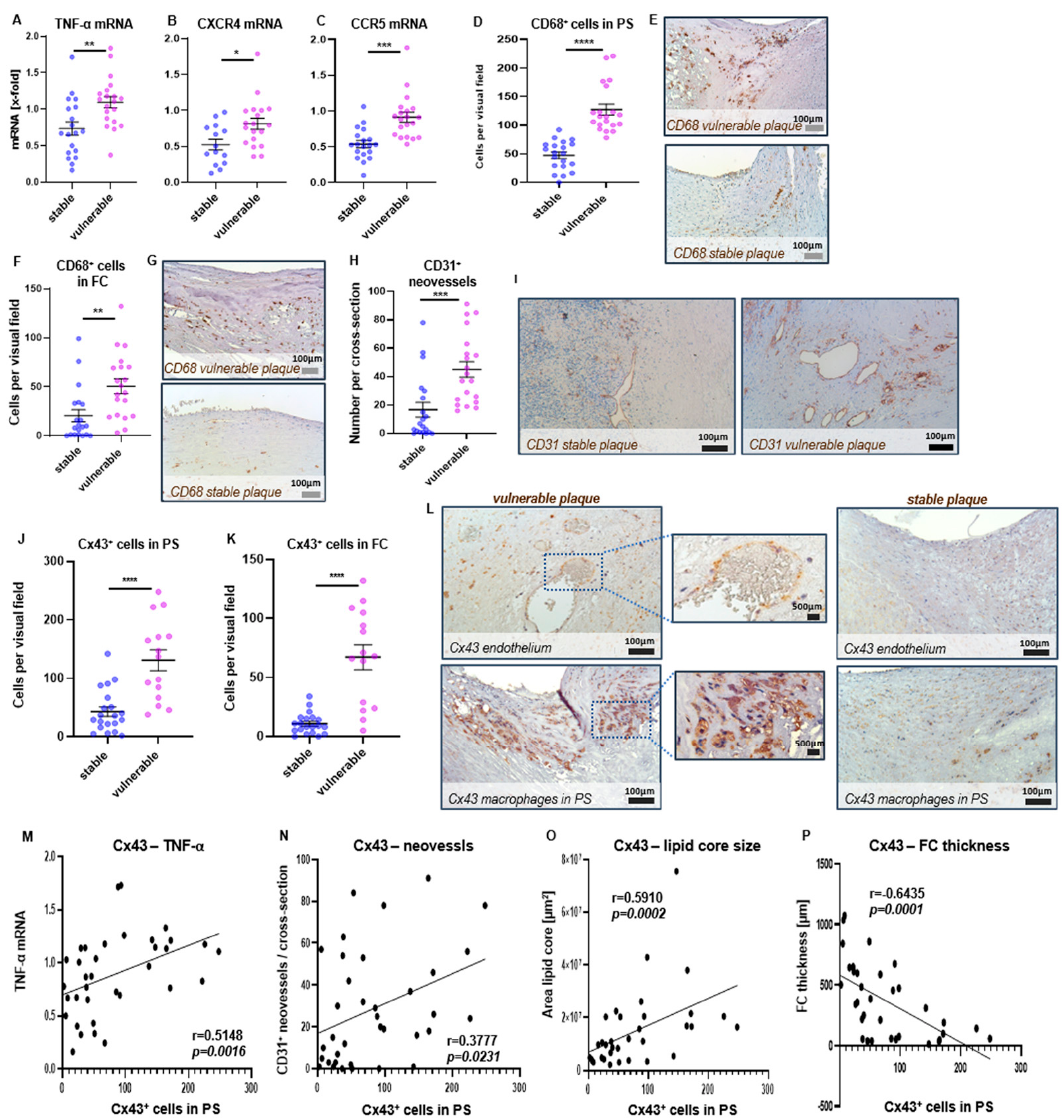
Figure 5. Role of Cx43 in clinical manifestation. ( A – C ) Transcription levels of TNF- α ( A ) and the chemokine receptors CXCR4 ( B ) and CCR5 ( C ) in stable and vulnerable plaques, n = 14–20. ( D – G ) Numbers of infiltrated CD68-expressing macrophages in the PS ( D ) and the FC ( F ), n = 20. Exemplary microscopic images of CD68-staining are shown of the PS I and the FC region ( G ). ( H , I ) Higher rate of CD31-stained neovessels in vulnerable compared with stable plaques ( H ), n = 20. Exemplary microscopic images, showing brown-stained endothelial cells of neovessels (scale bar = 100 µ m) ( I ). (J , K ) Increased numbers of Cx43-expressing cells in the PS region ( J ) and the FC ( K ) of vulnerable compared with stable plaques, n = 15–20. ( L ) Exemplary microscopic images show Cx43 expression by endothelial cells of neovessels (left upper image) and by macrophages in the inflammatory PS of a vulnerable plaque (right lower image), compared with Cx43-expressing cells in a stable plaque (right images). Data from gene plex assay and immunohistochemistry are presented as scatter dot plots showing mean ± SEM, dots represent values from individual experiments, unpaired t-test was used for analysis. ( M – P ) Spearman correlation analyses verify a correlation of Cx43 + cell counts with intraplaque TNF- α transcription, n = 35 ( M ), the rate of CD31 + neovessels, n = 36 ( N ), the mean area of the lipid core, n = 34 ( O ) and an inverse correlation with the FC thickness, n = 34 ( P ). * p < 0.05, ** p < 0.01, *** p < 0.001, **** p < 0.0001. Table 2. Spearman correlation coefficient r of human plaque parameters.